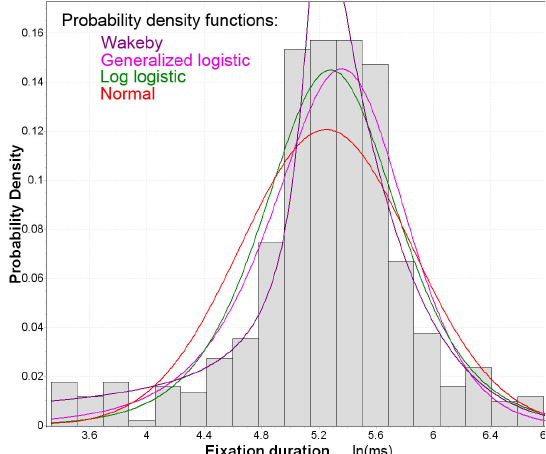
Figure 4. Fitting probability density functions to an em- pirical fixation-duration distribution. Distribution histo- gram of the 1st/2 fixations (N=509) of Participant 2 in the category-count condition is given as a representative example. The top-three best-fitting probability density functions are given: Wakeby, generalized logistic, and log-logistic, plus the normal distribution. The empirical data were statistically indistinguishable from each of the top three distributions (p > .1 on Kolmogorov-Smirnov tests), but different from the normal distribution (p <